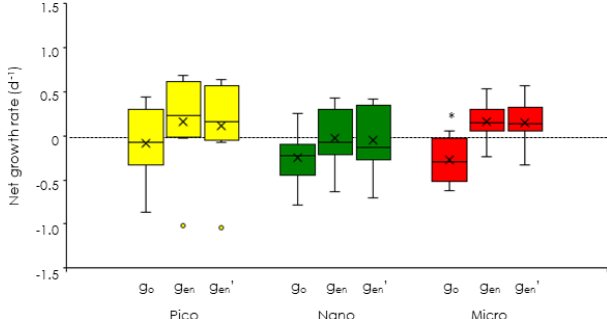
Figure 7. Comparisons of phytoplankton net growth derived from the dilution experiments (EXP b ) among the three different meth- ods. g o : observed net growth rates without enrichment in the nondi- luted bottles. g en : observed net growth rates with enrichment in the nondiluted bottles. g (cid:48) en : estimated net growth rates subtracting the mortality rates ( m ) from the maximum growth rates ( g max ). Box- and-whisker diagram at each nitrate concentration was compiled from the results conducted at the eight stations. Asterisk means sig- nificant difference between g o and g en (Welch’s t test, p <0.05). The symbols have the same meaning as in Fig.